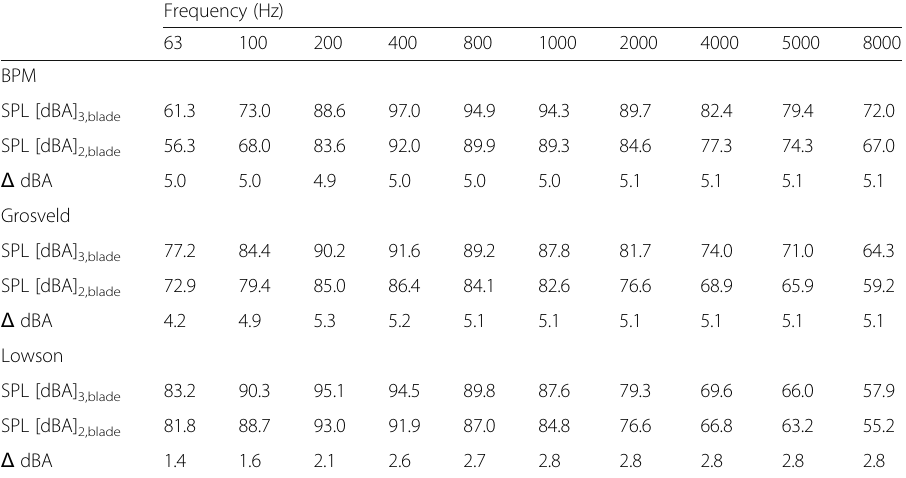
Table 1 Comparison of change in computed sound power level, L wA for three and two blade